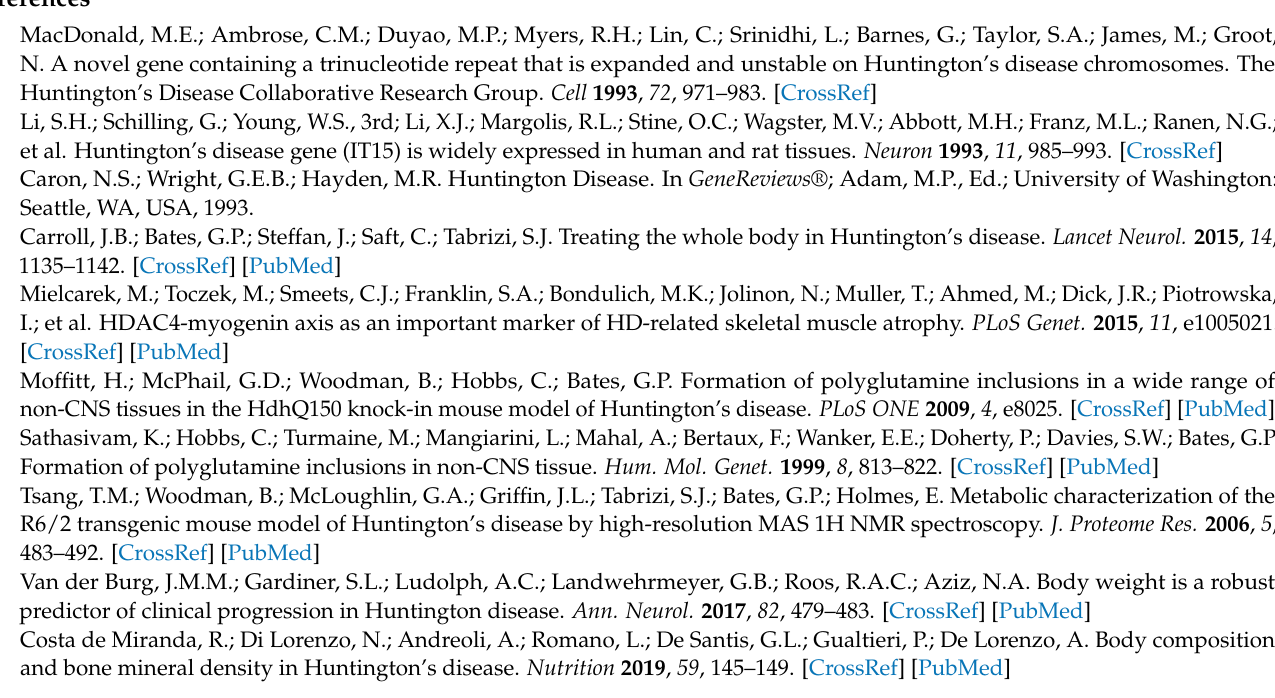
Figure A2. mRNA expression levels of 12 investigated steroid biosynthesis-related genes in the testis of middle-aged male WT and BACHD rats (7 months of age; WT, n = 6–7; BACHD, n = 7–8). Data are represented as individual values and mean ± SEM; statistical significance was determined by Student’s t -test. * p ≤ 0.05; ** p ≤ 0.01.